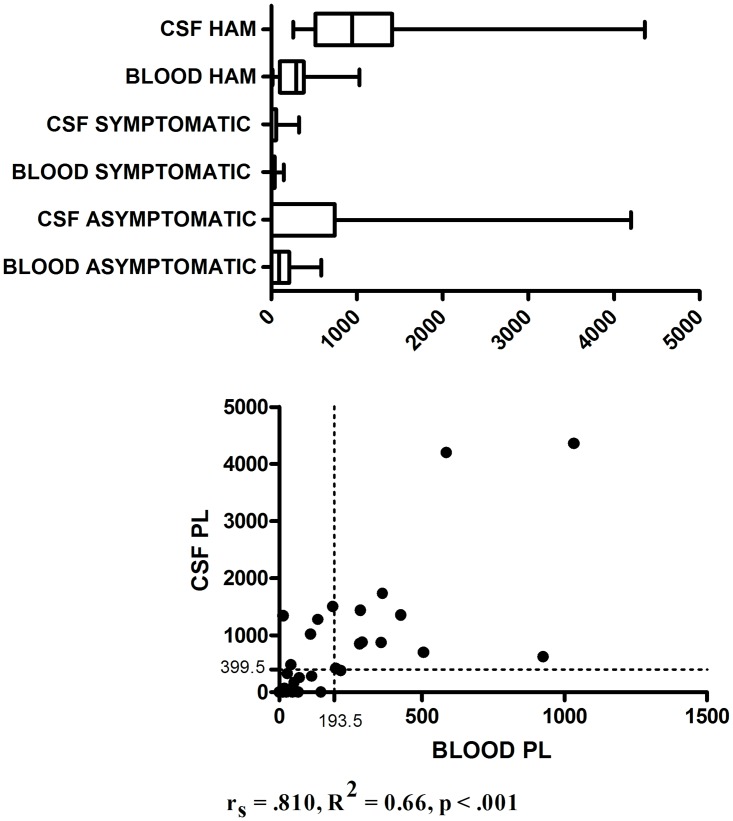
Blood and CSF proviral load (copies/103 cells): distribution by group (above) and correlation (below).The dotted lines represent the proviral load cutoff points to discriminating between HAM/TSP and asymptomatic groups.